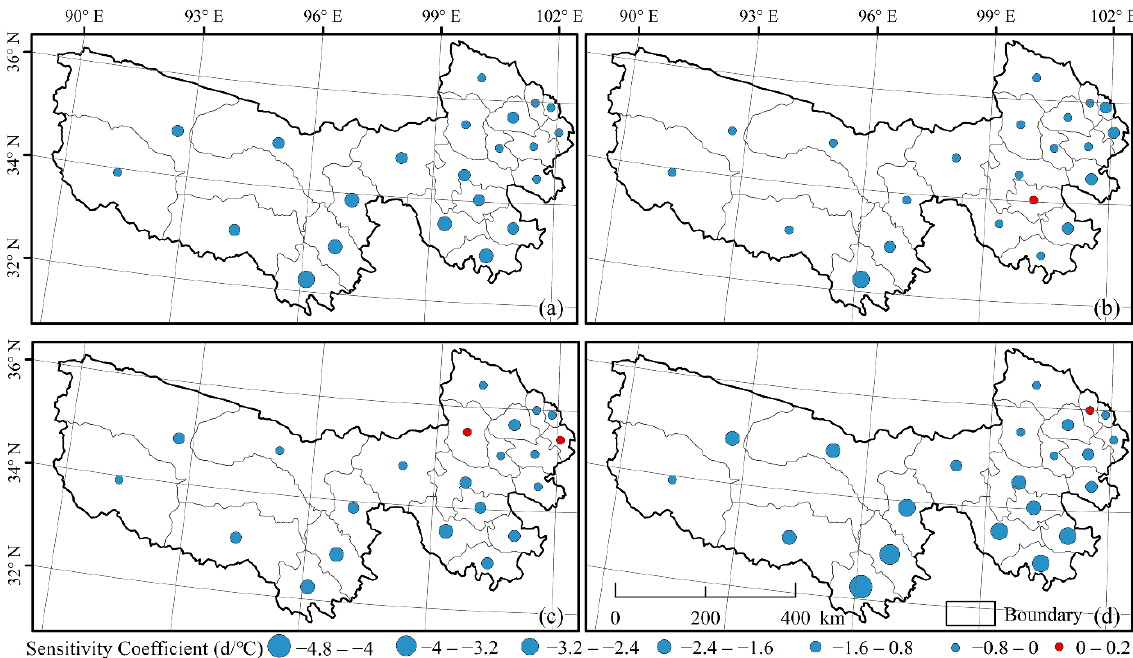
Figure 9. Spatial distribution of the sensitivity coefficients between the SOS of the vegetation and air temperature in March ( a ), April ( b ), May ( c ) and March – May ( d ) in the Three-River headwaters region.